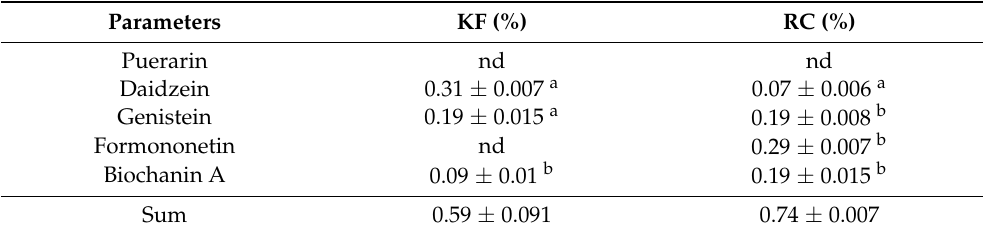
Table 1. Results of quantification of the isoflavones of kudzu flowers and red clover flower extracts.